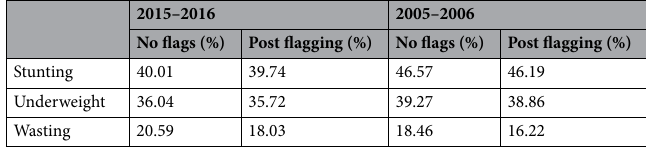
Table 4. Prevalence estimates of anthropometric failures before and after flagging.